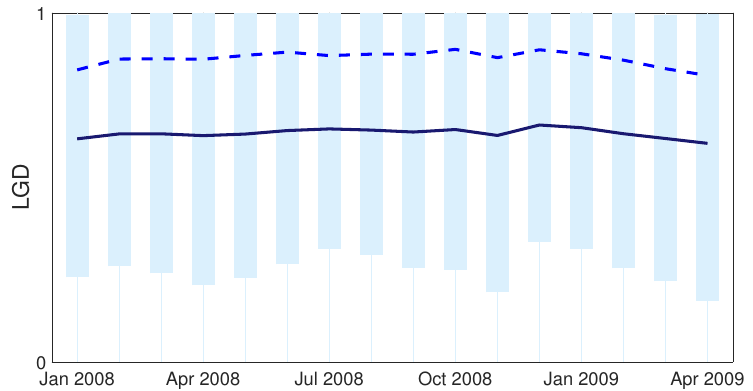
Figure 1. Distribution of LGD data with the mean (solid line). median (dashed line) and boxplot of data for each month over the observation period shown.